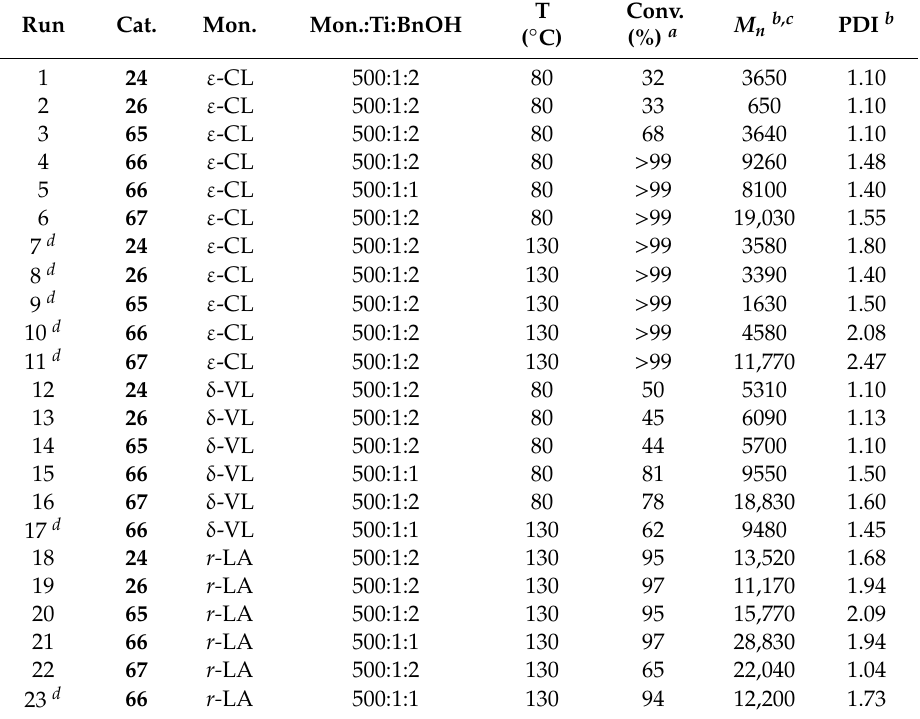
Table 21. ROP of cyclic esters catalyzed by 24, 26, 65–67